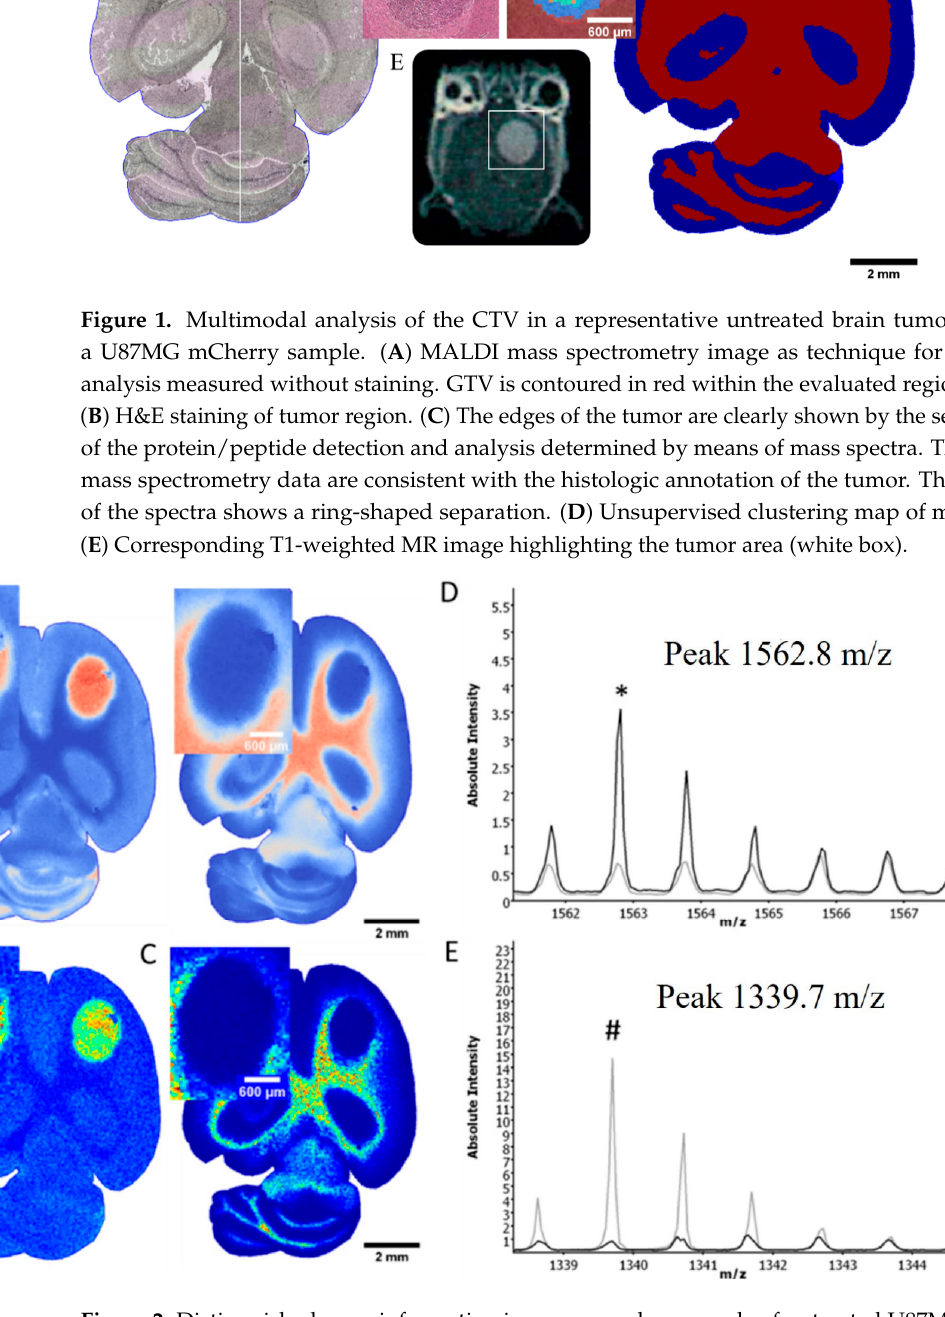
Figure 2. Distinguished mass information in one exemplary sample of untreated U87MG ‐ mCherry tumor and normal brain tissue. Principle component analysis of mass spectra demonstrates clusters of similarities and distinctions based on their measurement characteristics, showing a clear separa ‐ tion of tumor and brain tissue ( A ). Tissue ‐ dependent mass spectra show differences in mass distri ‐ bution of both tumor ( B ) and normal tissues ( C ), e.g., mass 1562.8 m/z as tumor peak (( D ); asterisk *), or mass 1339.7 m/z as marker for normal tissue (( E ); octothorpe #). The black line ( D , E ) represents mass spectra of the whole tumor area, whereas the grey line represents mass spectra of the normal brain tissue in the same content area.